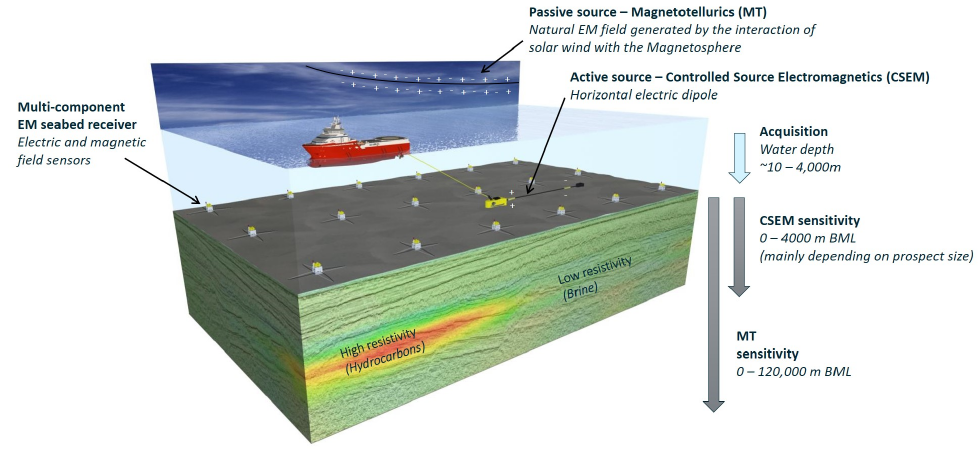
Figure 1. CSEM acquisition scheme and the sensitivity below the mud line (BLM) of the MT and CSEM methods. Courtesy of